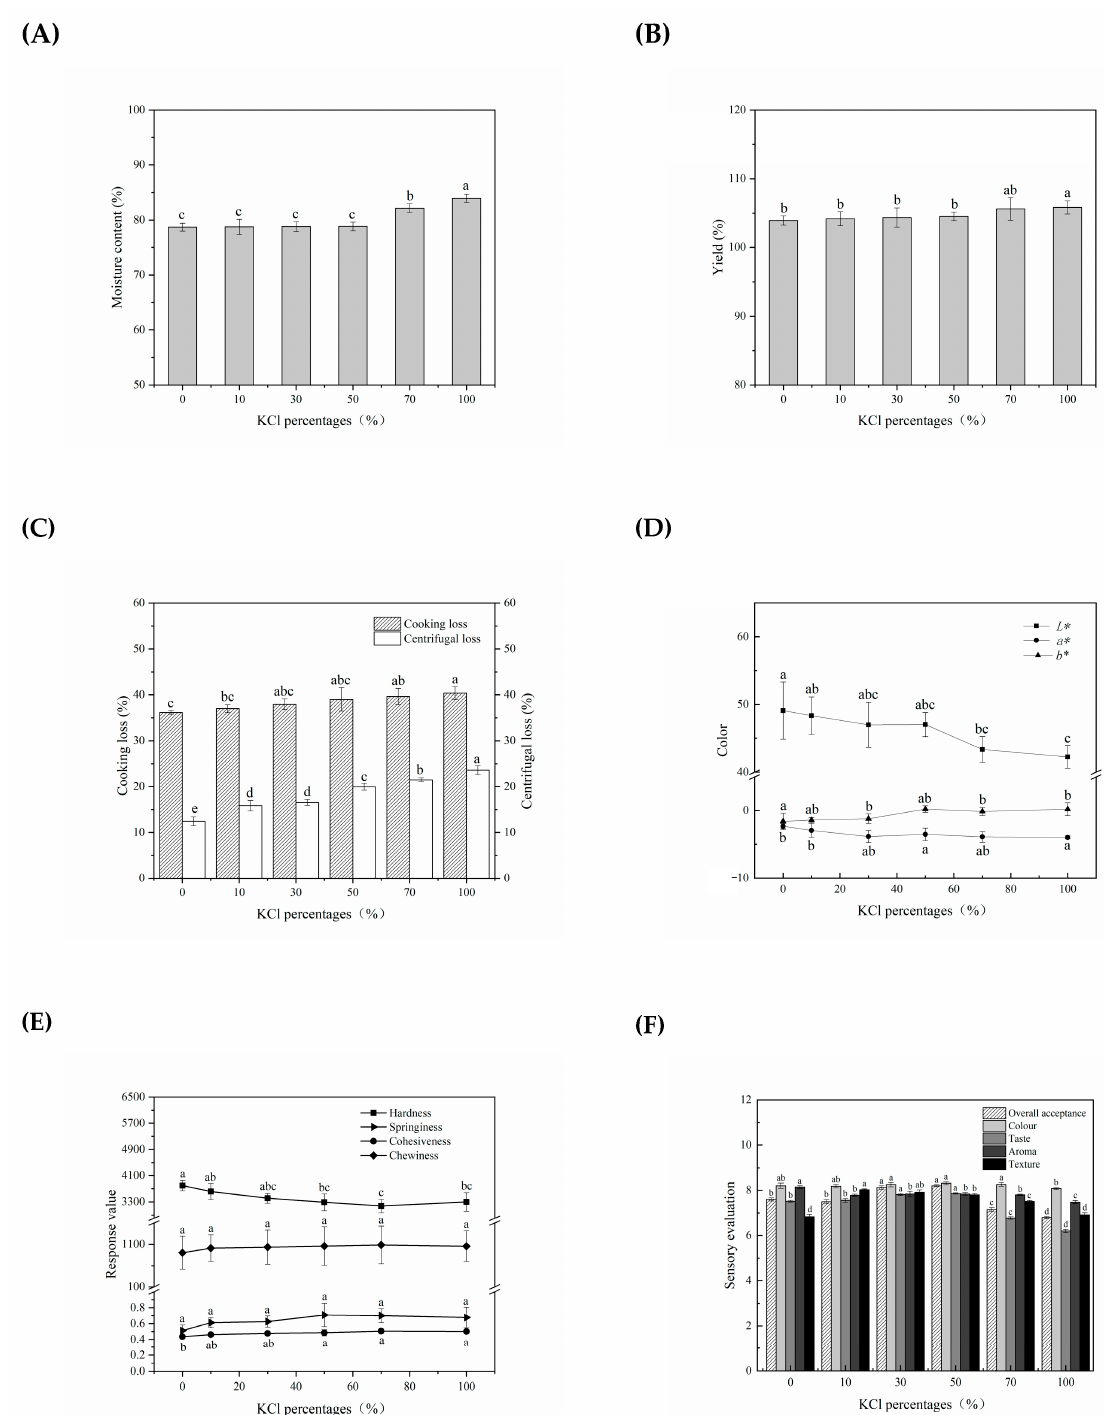
Figure 4. Change in quality properties of salted tilapia fillets as affected by different replacement of NaCl with KCl. ( A ) Moisture content; ( B ) yield; ( C ) water-holding capacity; ( D ) color; ( E ) texture profile; ( F ) sensory evaluation. Values with different lowercase letters are significantly different at p <